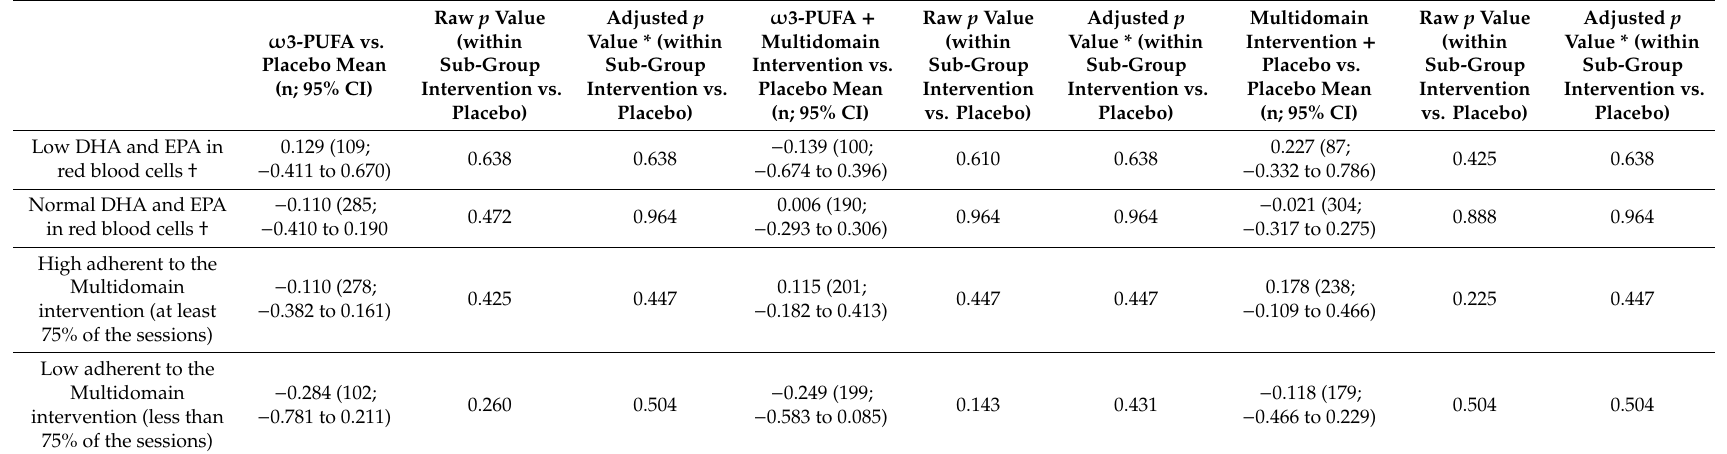
Table 7. Estimated 3-year mean di ff erence in change from baseline on total SPPB score in the three intervention groups compared with the control group (95% CI).